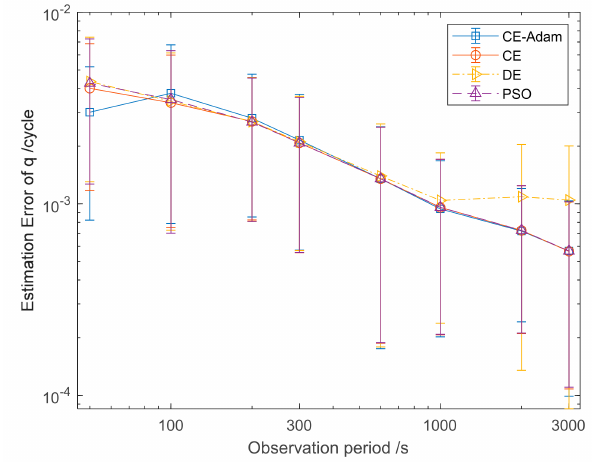
Figure 5. Estimation error of q for cross-entropy (CE), differential evolution (DE), particle swarm optimization (PSO) and CE-Adam algorithm.